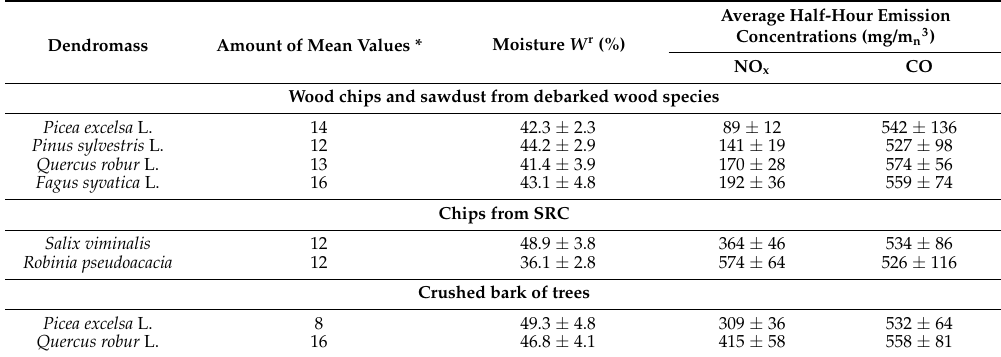
Table 3. Average concentrations of nitrogen oxides NO x and carbon monoxide CO in dry combustion gases (converted to 11% O 2 ). Dendromass Amount of Mean Values * Moisture W r (%) Picea excelsa L. Pinus sylvestris L. Wood chips and sawdust from debarked wood species